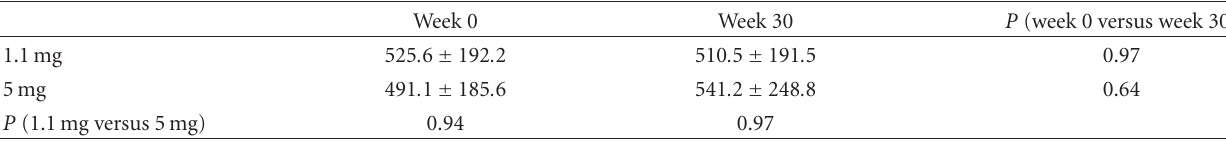
Table 7: Estimated dietary total folate intake ( μ g